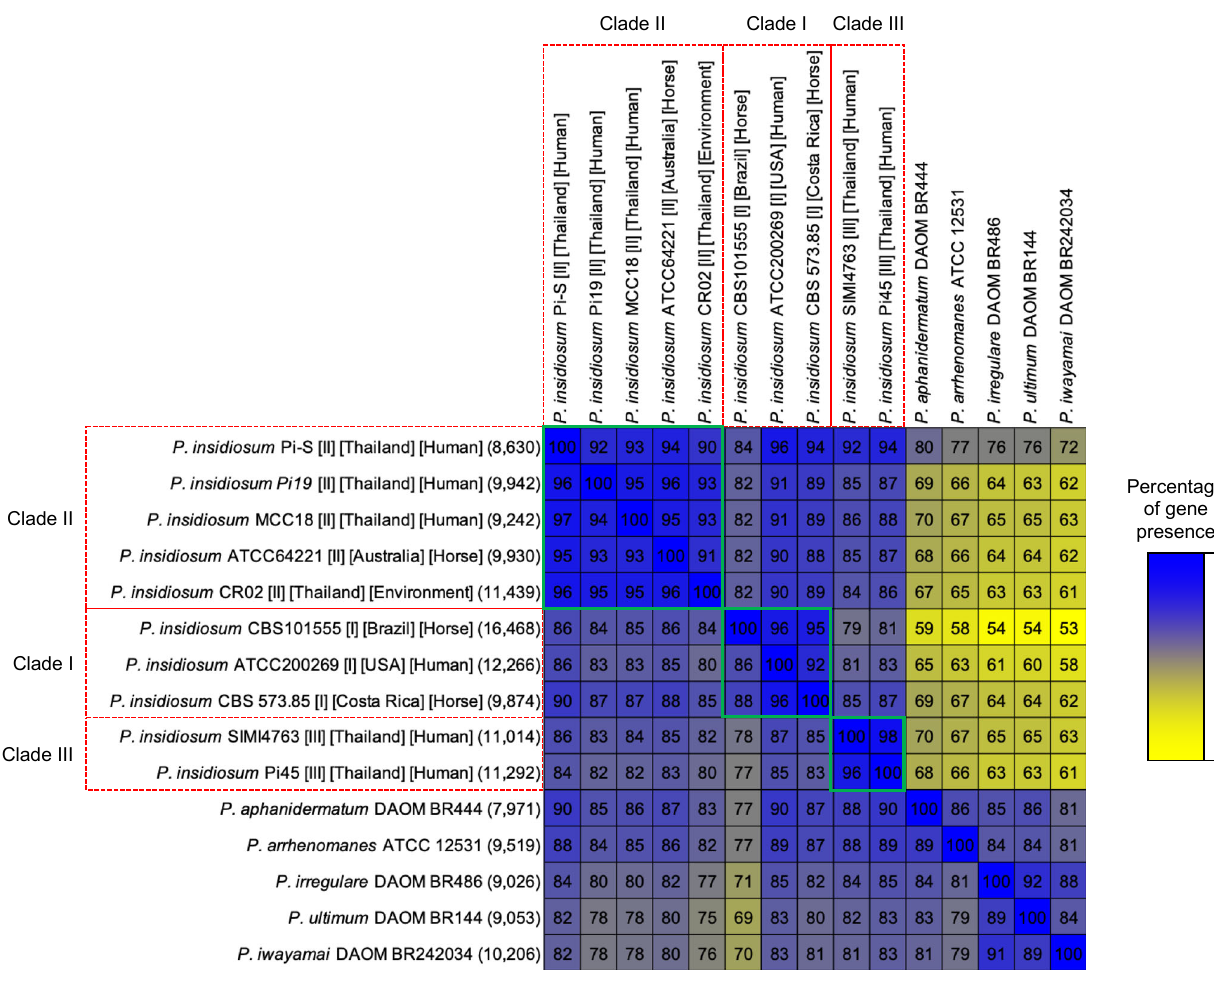
Figure 4. All pairwise gene content comparisons of 10 P. insidiosum strains and 5 other Pythium species. The number in each parenthesis indicates the total number of non ‐ redundant genes in the genome of each organism used in this analysis. The number in each cell shows the percentage of genes present in the genome shown on the left that is also present in the corresponding genome shown at the top of the table. Red boxes show the P. insidiosum strains assigned to rDNA ‐ based genotype clades I, II, and III. Green boxes demonstrate the percent gene presence within the same clade. Color gradience indicates the degree of gene presence (%).